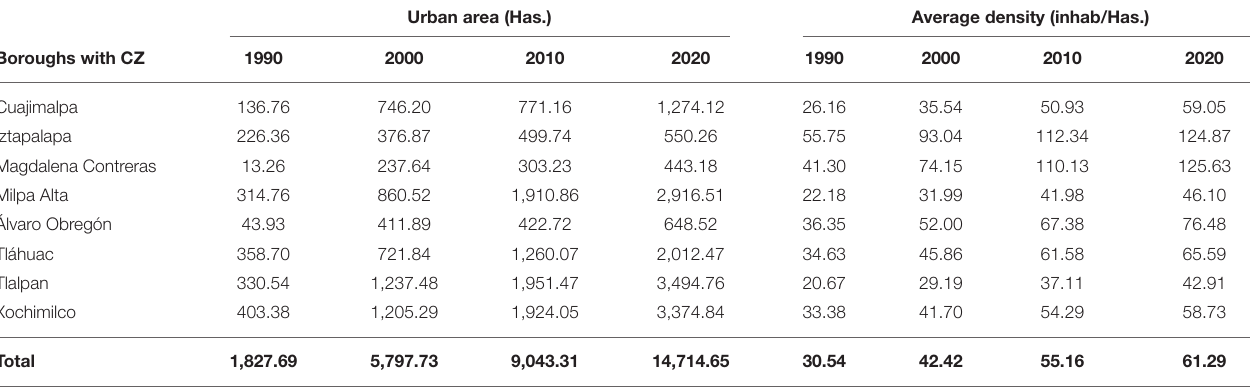
TABLE 4 | The conservation area: urban expansion and average density (inhab/Ha), 1990–2020. Urban area (Has.) Average density